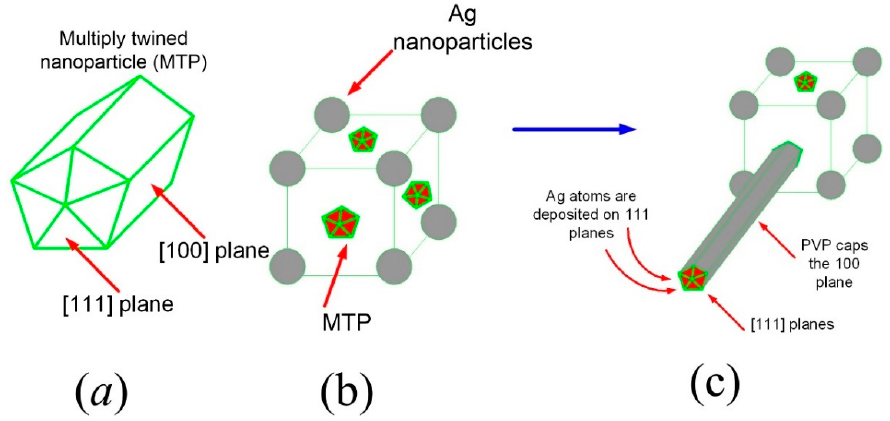
Figure 1. Schematic diagram for the growth mechanism of ( a ) MTPs, ( b ) AgNPs, and MTPs-decorated nanocrystals, and ( c ) anisotropically elongated AgNWs from the nanocrystal surface.